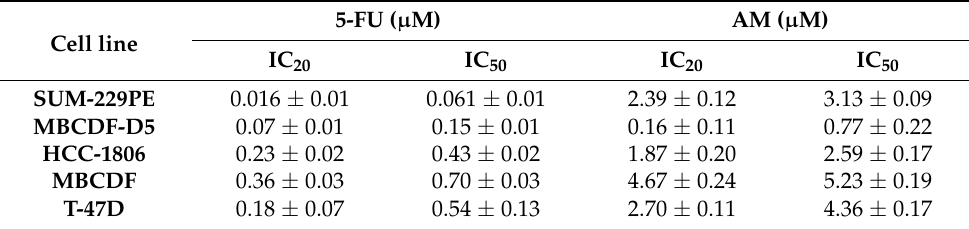
Table 2. IC 20 and IC 50 values of 5-fluorouracil and α